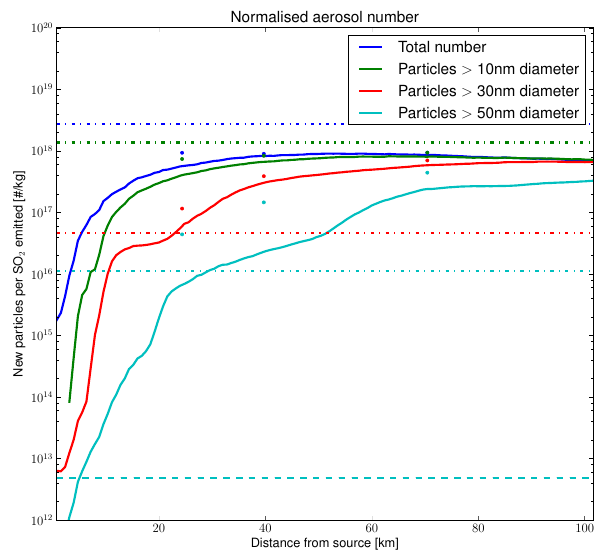
Fig. 7. Additional predicted particles per kg SO 2 emitted versus distance from the Conesville power-plant, summed over the plume. See Sect. 3.1 for a description of the calculation. Model resolu- tion is 800 × 800 × 40m. Dots indicate aircraft observations, solid lines indicate model results, dashed lines indicate the values used by Dentener et al. (2006), and dashed-dotted lines indicate the values used by Adams and Seinfeld (2003). Coloring indicates size range of particles. Essentially all particles in the Dentener et al. (2006) distribution are larger than 50nm, so these lines